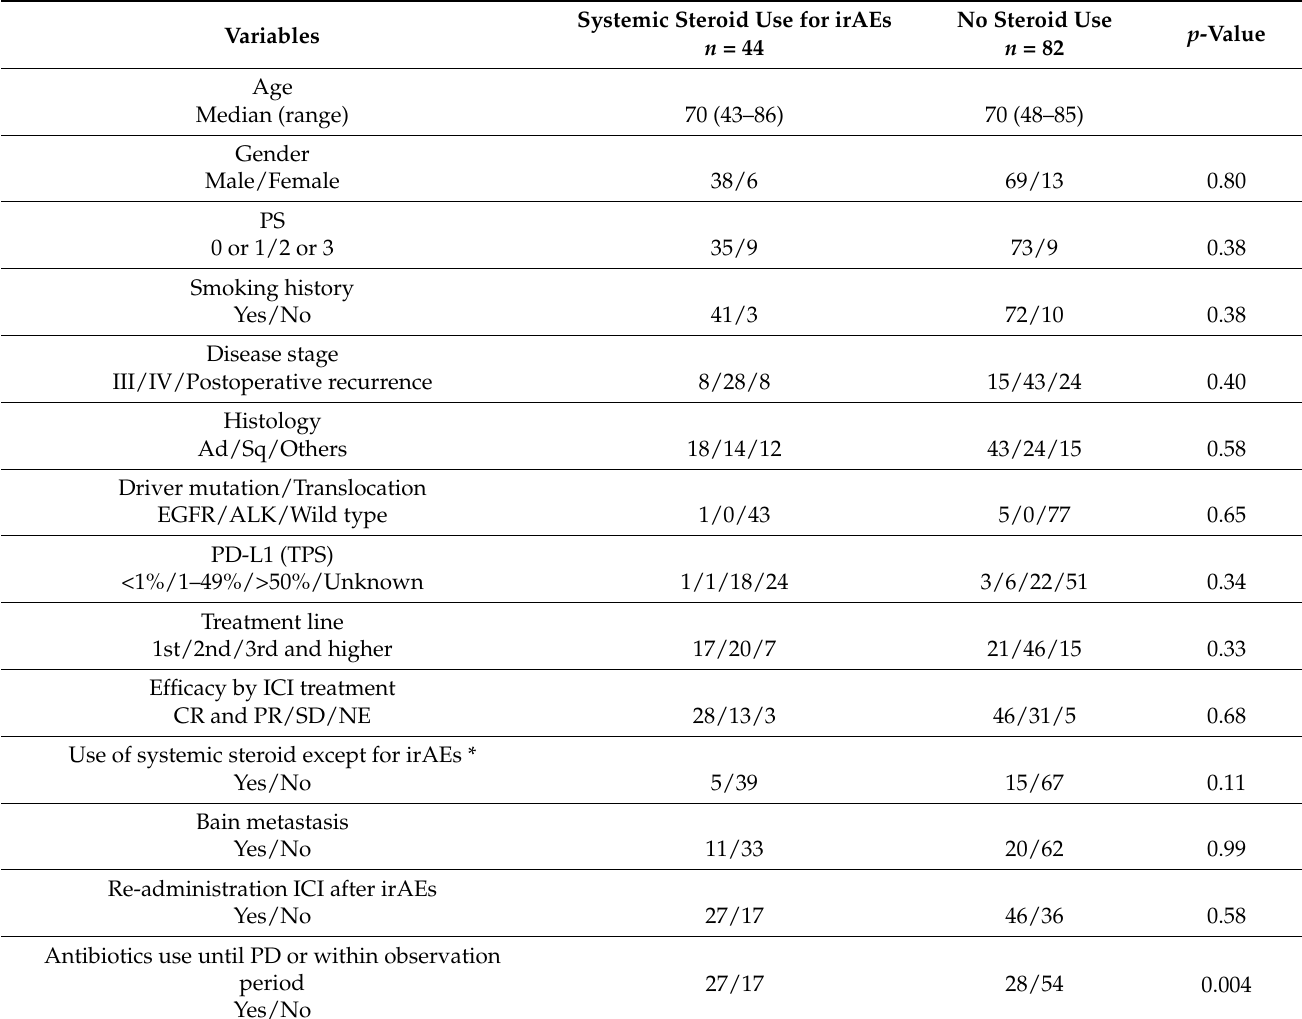
Table 1. Patient characteristics ( n =